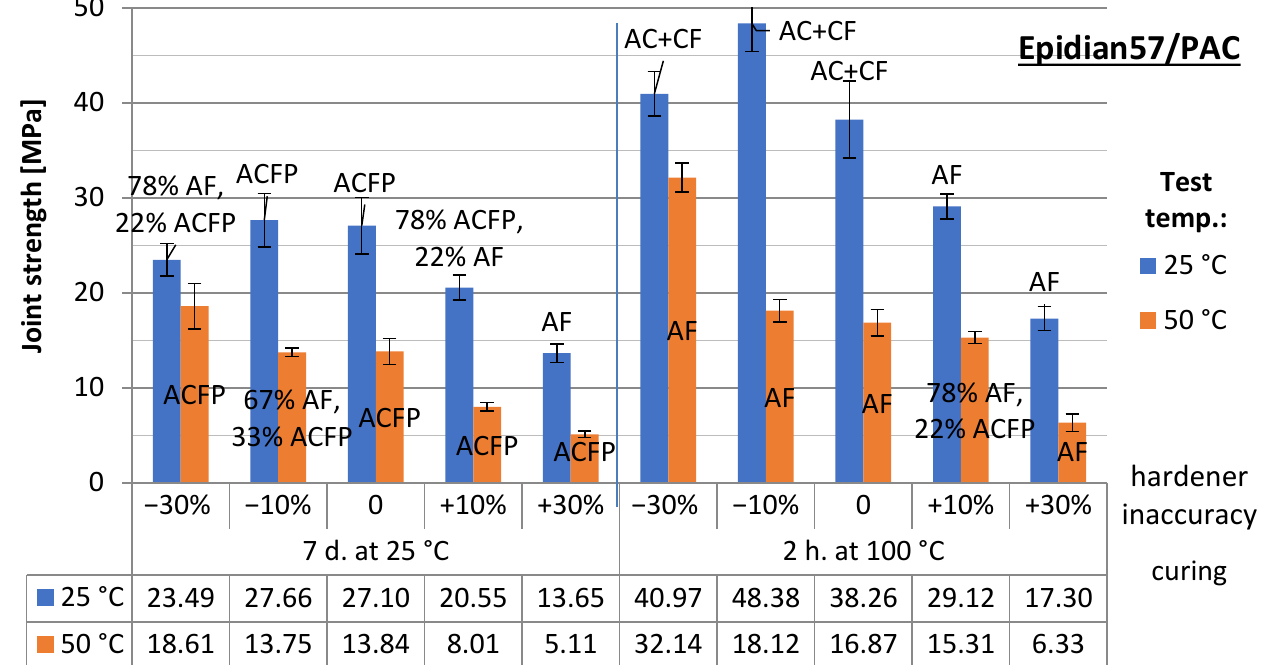
Figure 4. Test results for the adhesive joint strength made with Epidian57/PAC.